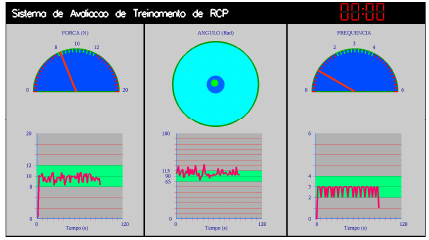
Figure 4. CPR training interface: pressure, angle and frequency.